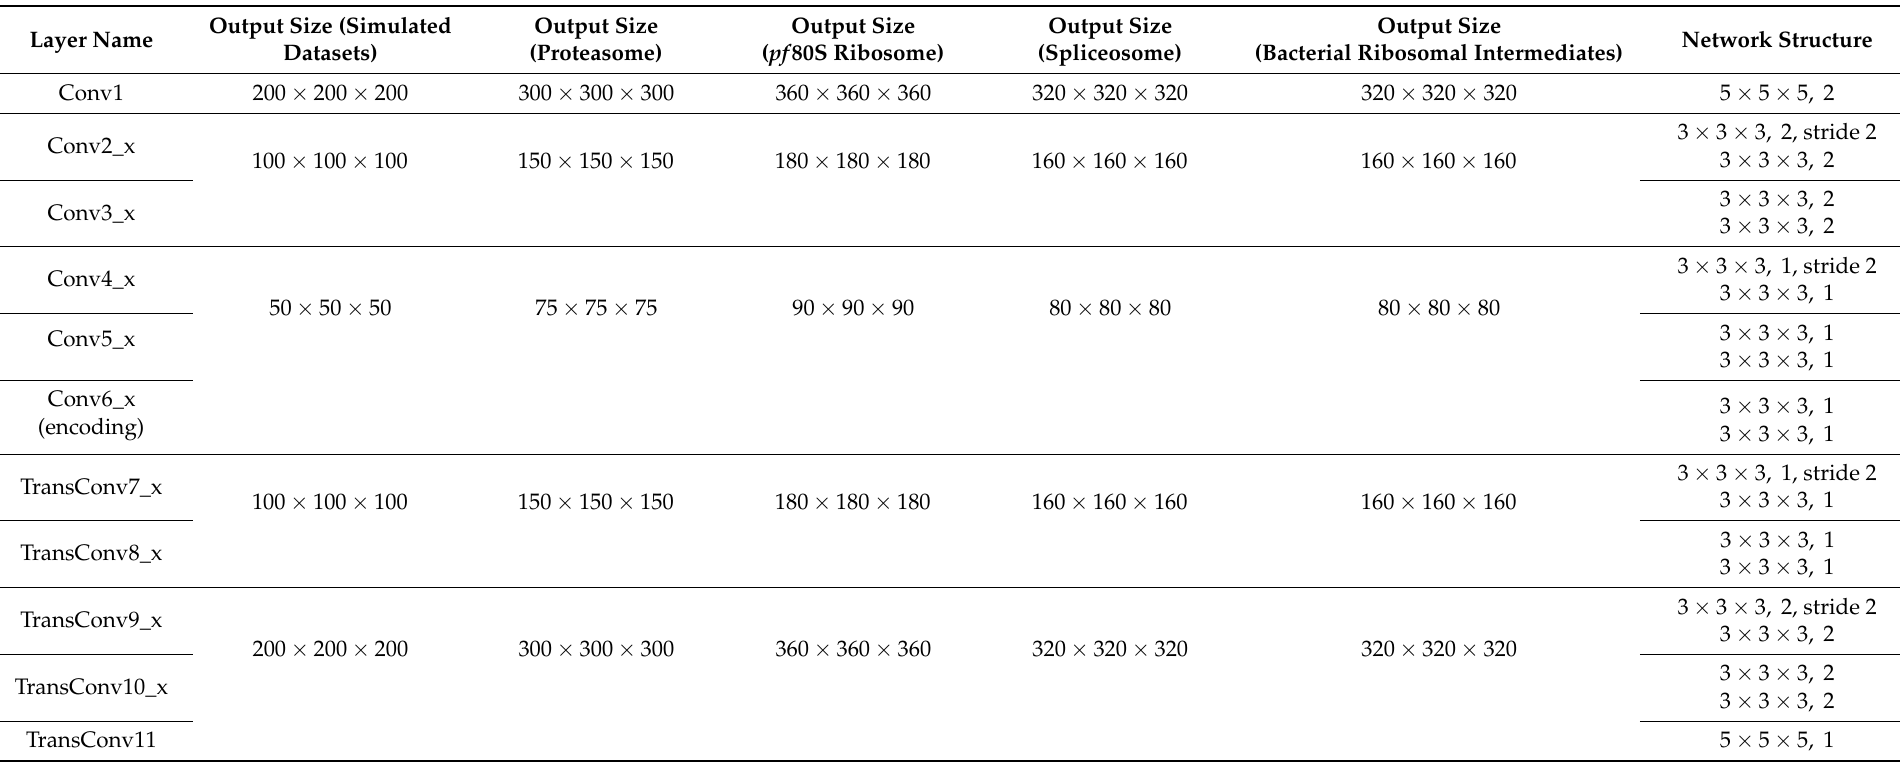
Table 1. Hyperparameters of the deep residual networks in the 3D autoencoder. Optimizer: Adam. Epochs: 50. Initial learning rate: 0.01. A factor of 0.1 and patience of 3 means that the learning rate will times 0.1 (factor) if the loss function does not improve in 3 (patience)